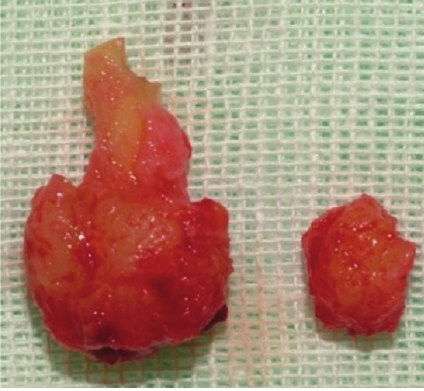
Figure 4: Macroscopically the two samples presented as a nodular, hard-elastic in consistency, the largest of which was adherent to the dental element.